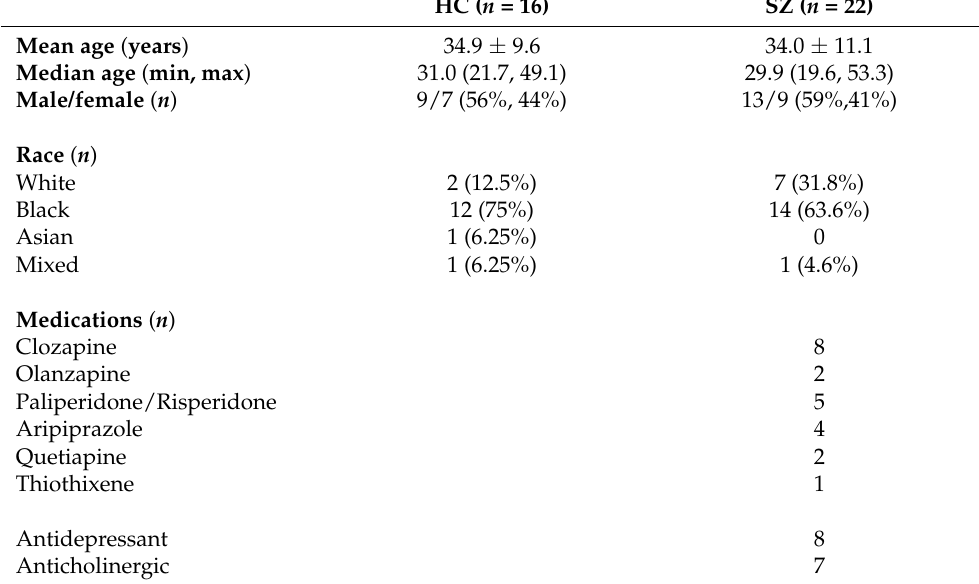
Table 2. Demographics of Study